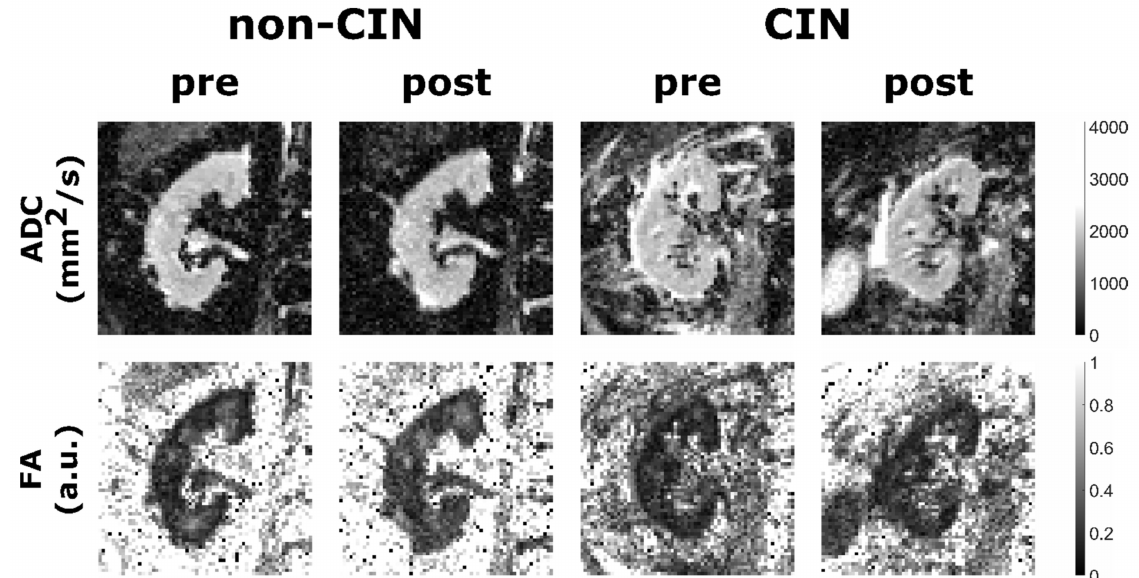
Figure 2. Examples of apparent diffusion coefficient (ADC) (first row) and fractional anisotropy (FA) (second row) parameter maps of a non-Contrast-Induced Nephropathy (non-CIN) and a CIN patient pre- and post-XCM. First two columns (patient 14): 82-years old male non-CIN patient with stable renal function measured by eGFR (62 to 69 mL/min), creatinine (1.11 to 1.02 mg/dL), and cystatin C (1.37 to 1.31 mg/L) in the post-interventional period. Second two columns (patient 13): 84-years old male CIN patient with a significant alteration of eGFR (71 to 49 mL/min), creatinine (0.97 to 1.33 mg/dL), and cystatin C (1.37 to 1.93 mg/L) 48 h post XCM